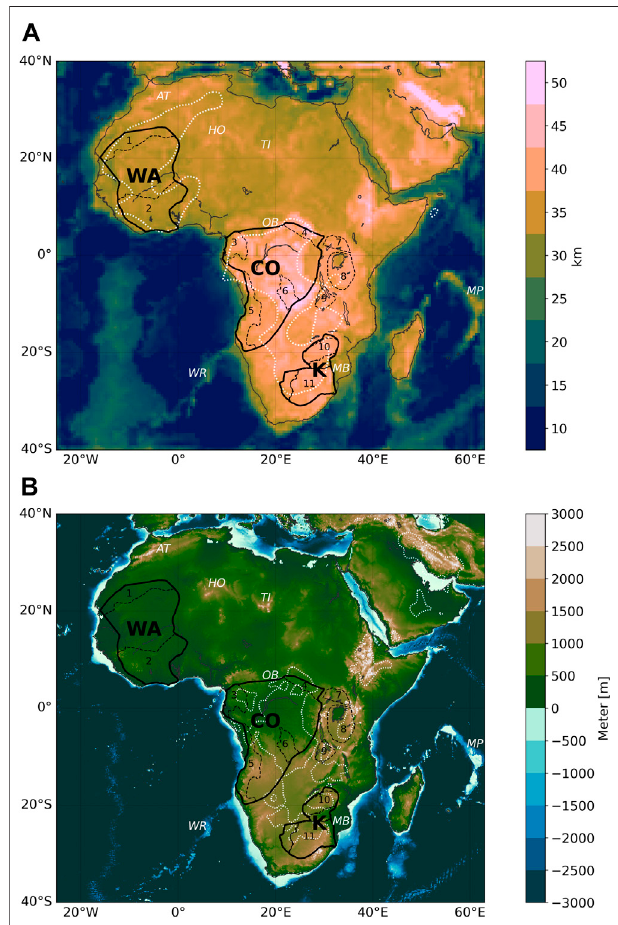
FIGURE 6 | (A) Final estimated Moho depth. Black solid contours indicate the extent of the West African Craton (WA), Congo Craton (CO) and Kalahari Craton (K), as seen in surface geology. Black dashed contours represent smaller cratons and individual shields. 1: Reguibat, 2: Man- Leo, 3: Gabon-Cameroon, 4: Bomu-Kibali, 5: Angola, 6: Kasai, 7: Uganda, 8: Tanzania, 9: Bangweulu, 10: Zimbabwe, 11: Kaapvaal. Contours are taken from Begg et al., 2009. Other tectonic domains that are discussed in the text are indicated in white italic letters. AT: Atlas Mountains, HO: Hoggar Mountains, TI: Tibesti Mountains, OB: Oubanguides Mobile Belt, MB: MozambiqueBasin,WR:WalvisRidge,MP:MascarenePlateau.Whitedotted lines indicate the +4 % dV s contours between 80 – 150 km, calculated from the AF2019 model. (B) Topographic map with same contours of cratonic and shield extent as in a). White dotted lines indicate the 40 km contour of the estimated Moho depth of